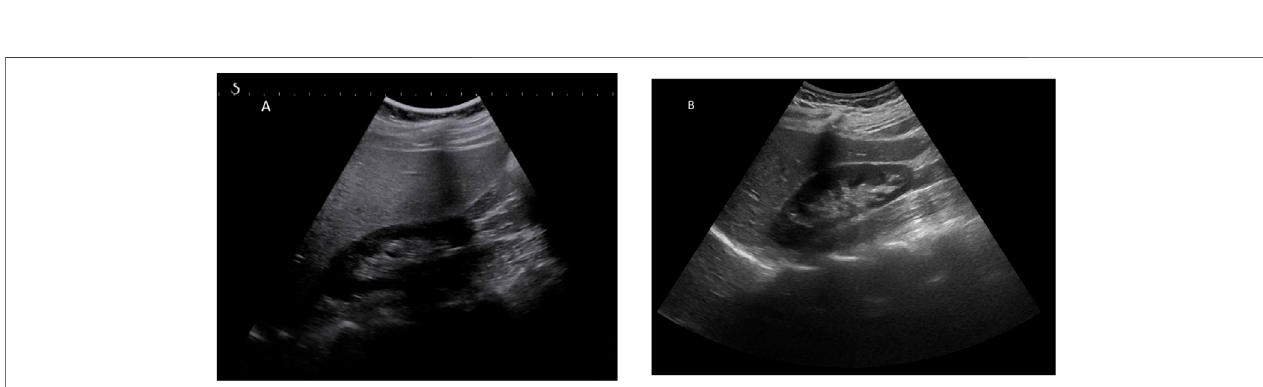
FIGURE 2 | Ultrasonographic features seen in both GlyH and liver steatosis. Caption: (A) A greyscale ultrasound image of the liver parenchyma compared to the kidneywillshow hyperechogenicity oftheliver inboth GlyHand fatty liverdisease,asseen inthis 40-year oldpatient with T1Dand NAFLD from ourclinic. (B) In anormal liver, the echogenicity of liver and kidney parenchyma is similar, as seen in this 42- year old patient with T1D from our clinic.